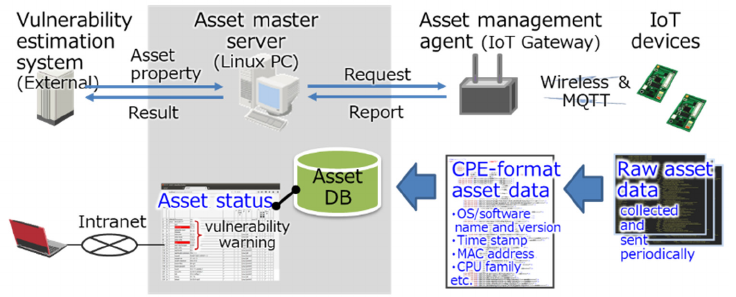
Figure 4. Architecture of asset configuration management system.